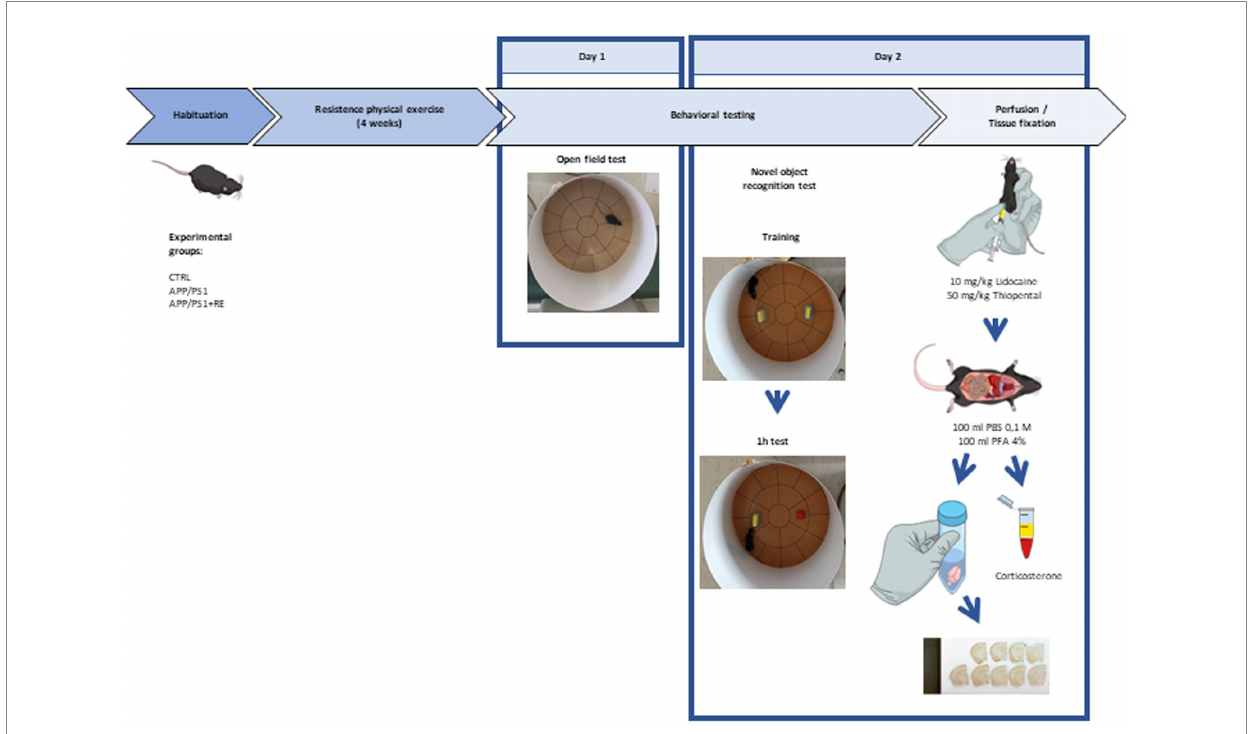
FIGURE 1 Experimental design. PBS: phosphate-buffered saline; PFA: